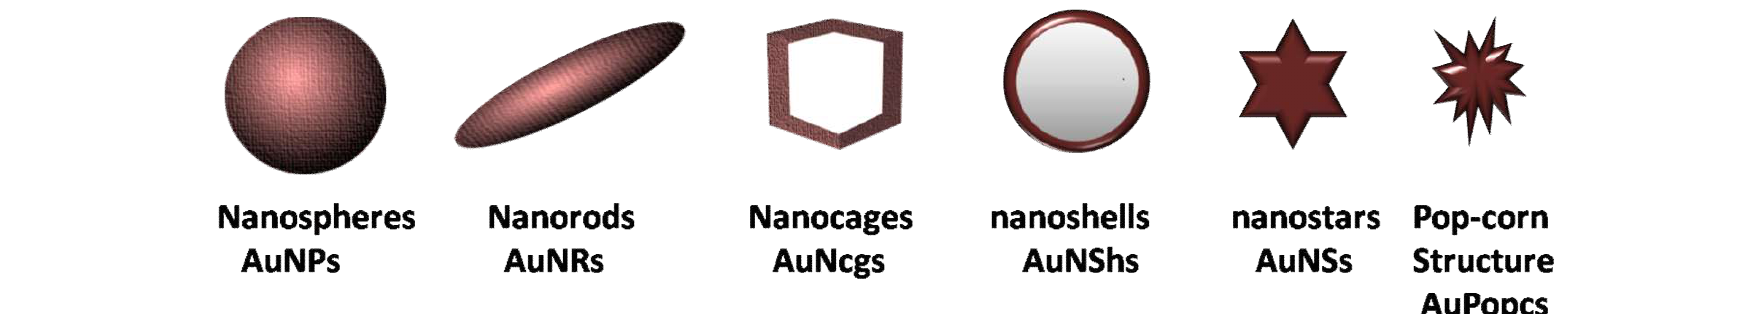
Table 2. Different shapes of gold nanoparticles in prostate cancer.